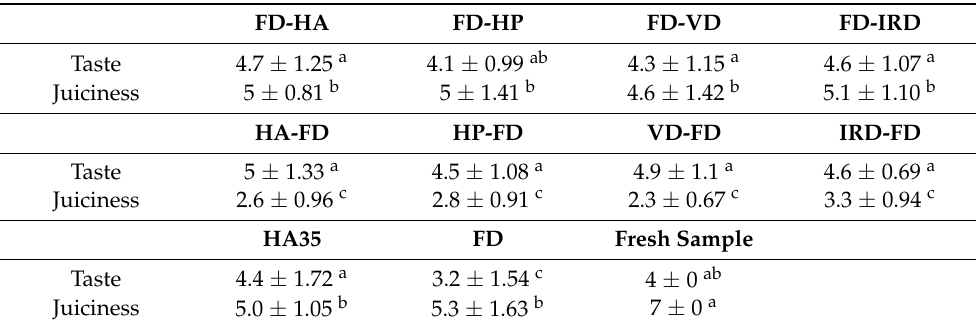
Values in the same indicator followed by different letters are significantly ( p < 0.05) different. Table A4. Sensory evaluation of FD combined drying at 65 ◦ C.